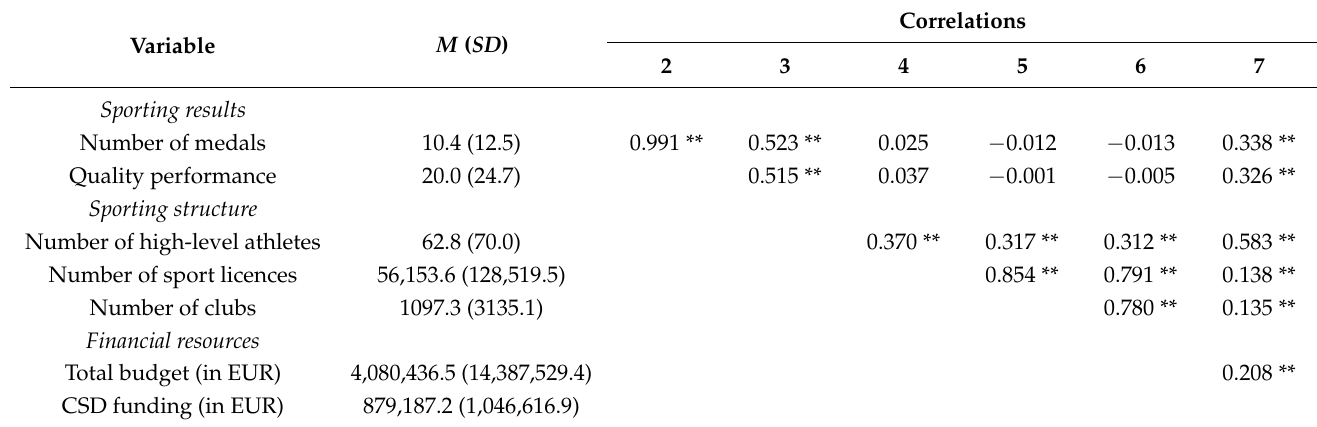
Table 2. Descriptive results and correlations between all the variables in the